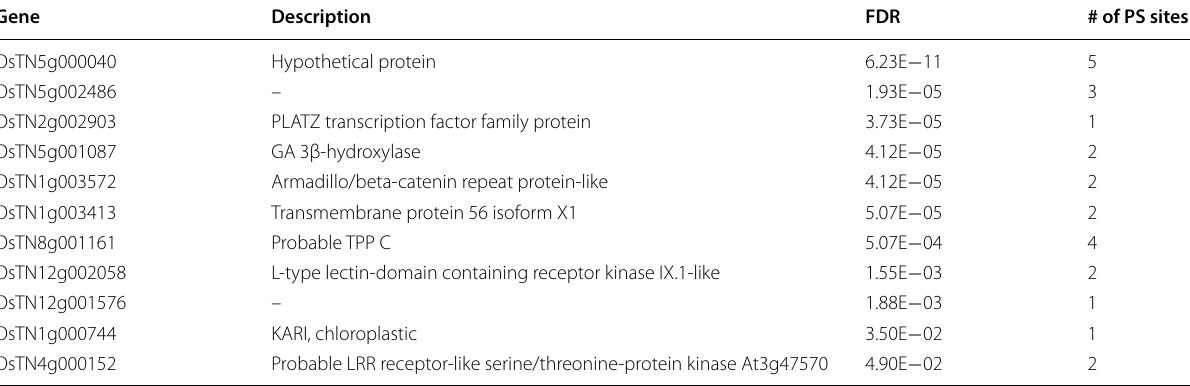
The criterion for positive selection was FDR <